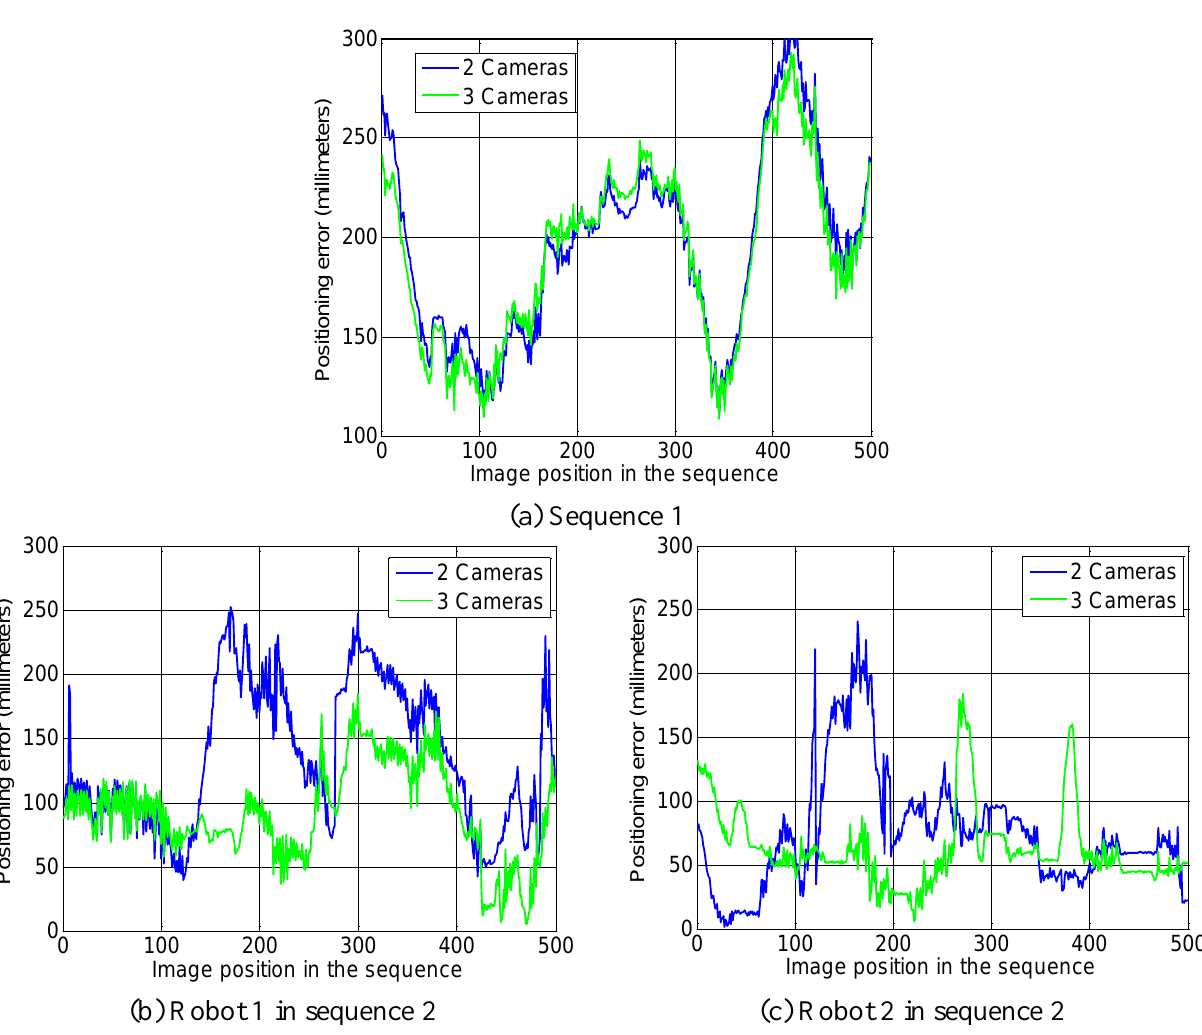
Figure 12. Positioning error (in millimetres) of the mobile robots, calculated using Equation (28) for 2 and 3 cameras. (a) Robot in the image sequence 1 (b) Robot 1 in the image sequence 2 (c) Robot 2 in the image sequence